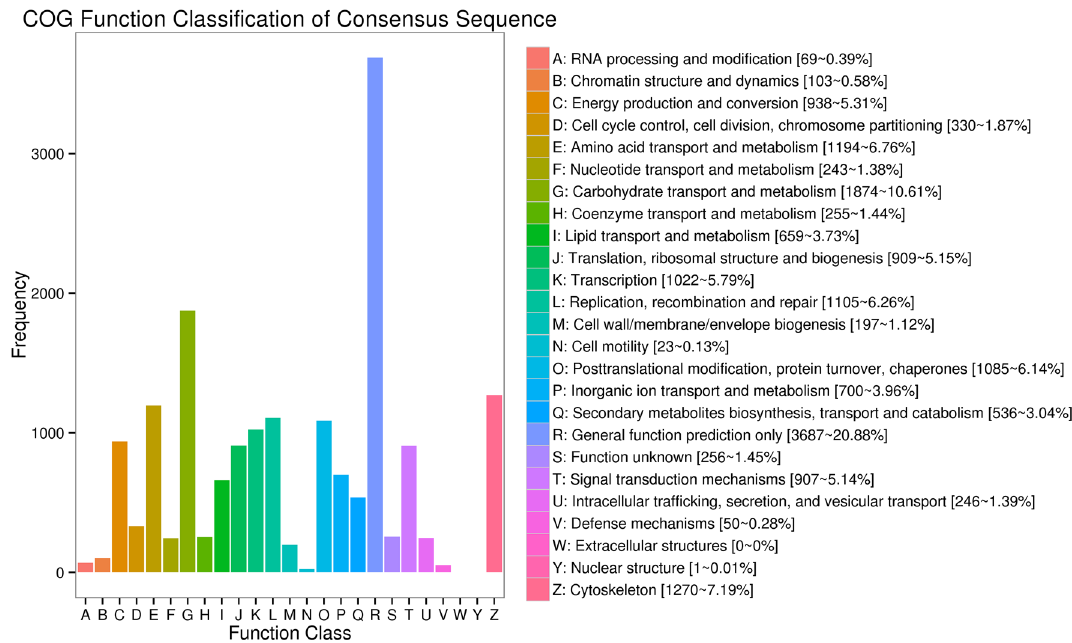
Figure 3. Cluster of orthologous groups (COG) classification of putative